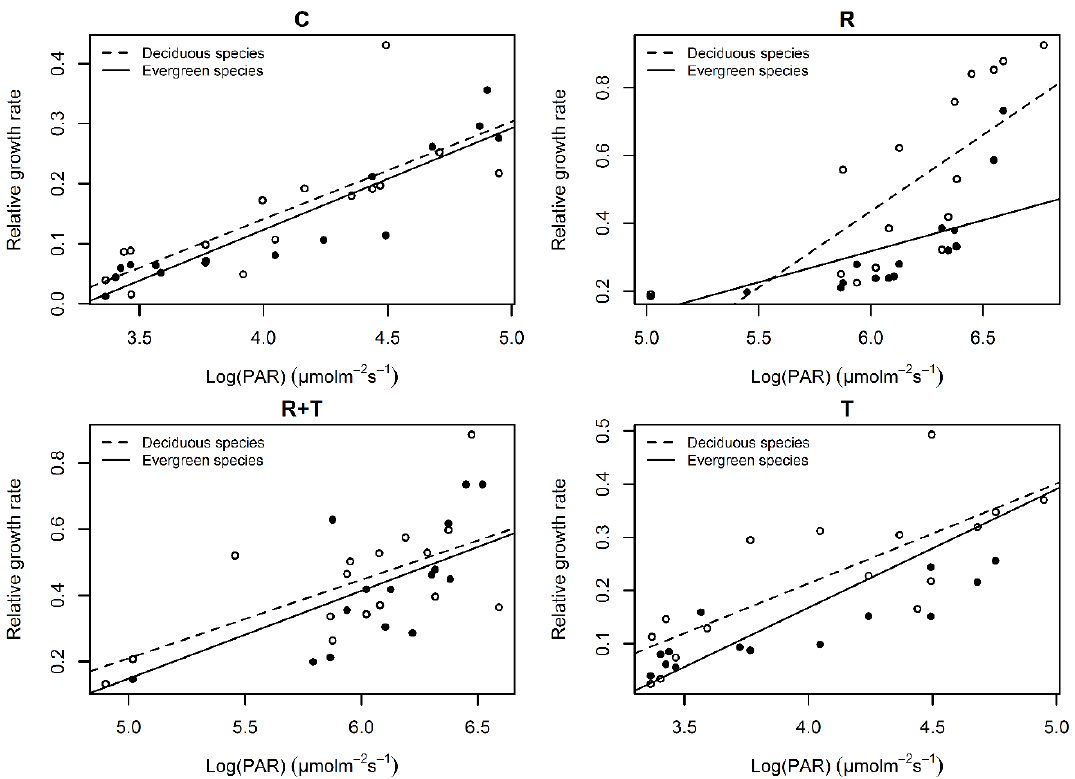
Figure 1. Effects of different treatments on seedling survival rates. Different letters ( a , b ) indicate significant difference ( p ≤ 0.05).